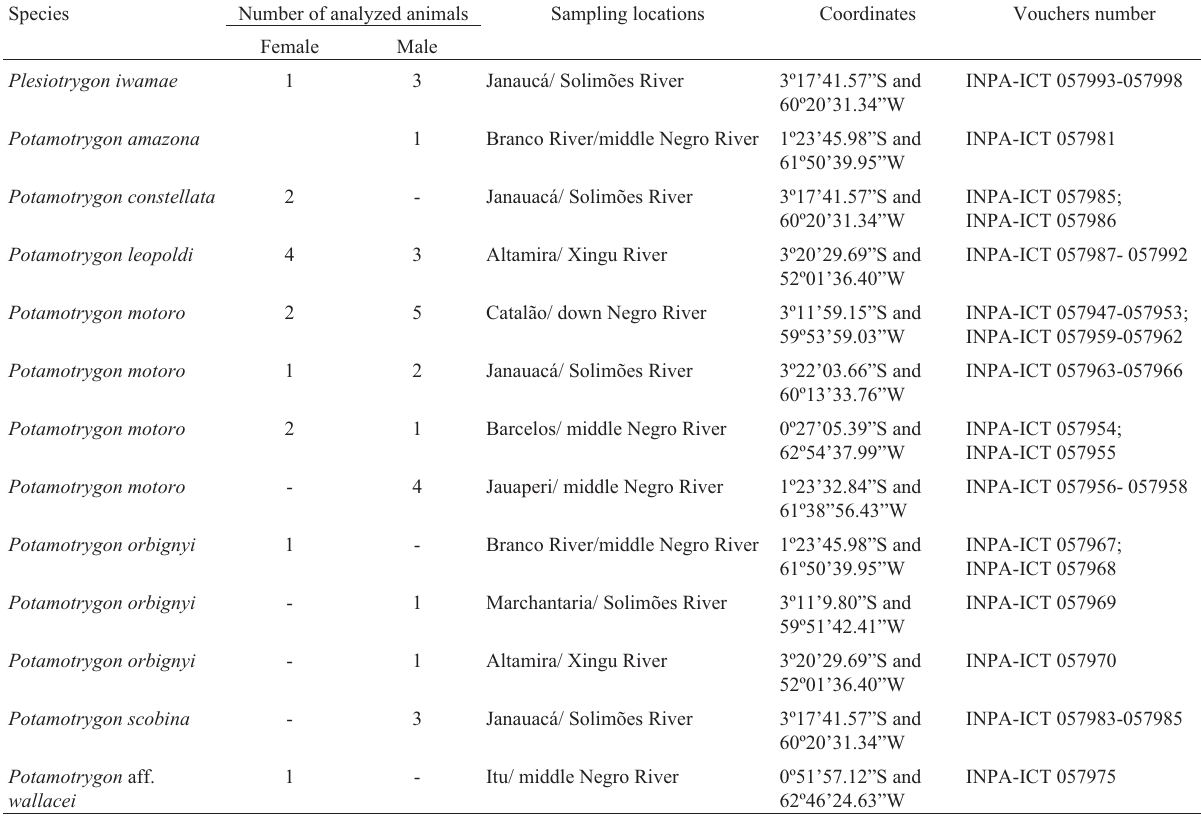
Table 1 - List of the species and the number of individuals analyzed in the present study by sampling locations. Species Number of analyzed animals Sampling